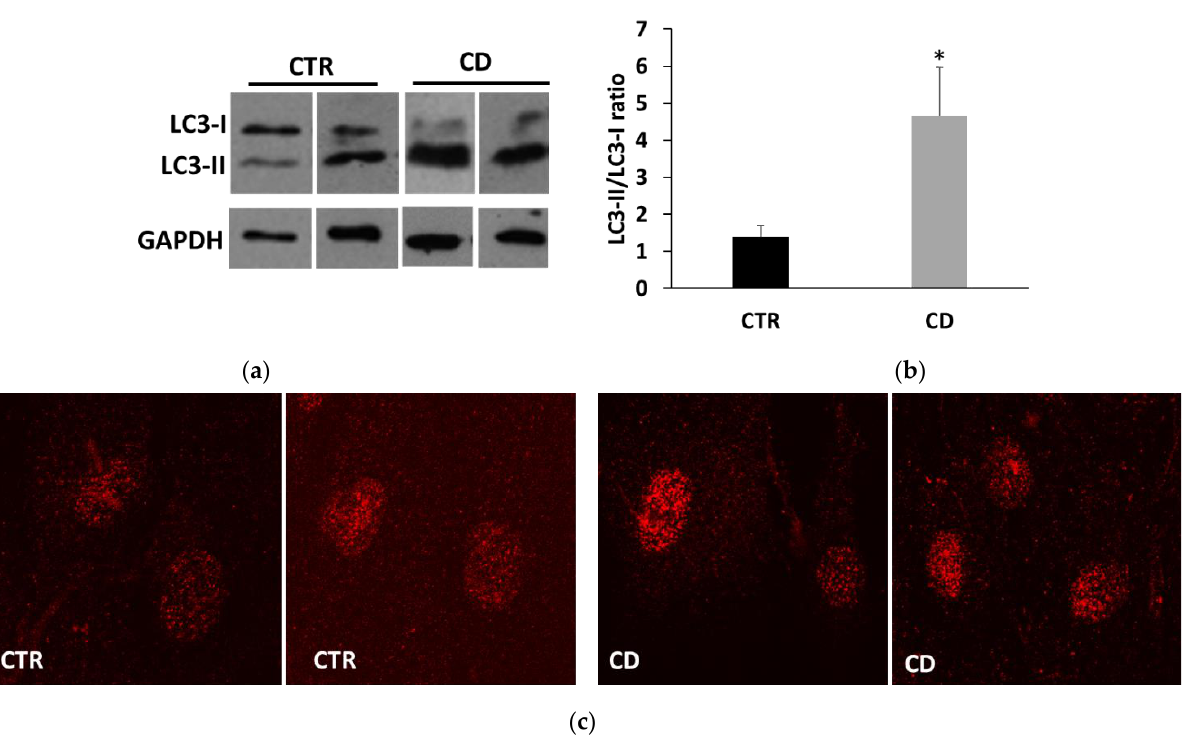
Figure 5. Basal LC3 expression. ( a ) Representative Western blot anti-LC3 showing basal levels of LC3-I and LC3-II on samples from two control and two celiac cultures. ( b ) Representation of ratio between LC3-II and LC3-I forms in samples from four controls and four CD cultures. Data are reported as mean ± SE. * p < 0.05 versus controls (Student’s t -test for unpaired data). ( c ) Representative confocal images of LC3 in cells from two control cultures and two CD ones (63× magnification).